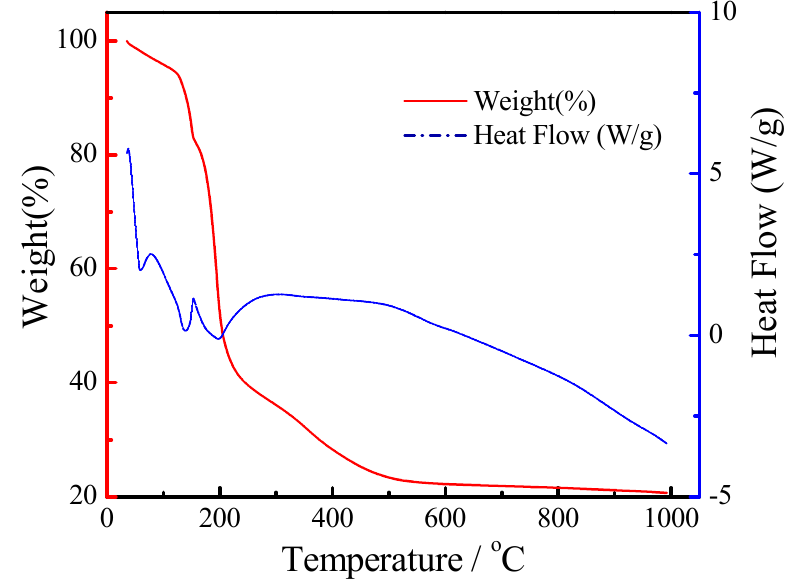
Figure 1. TGA-DSC test of the Zr 0.92 Y 0.08 O 2- α (8YSZ) gel heated at 15 °C·min − 1 .